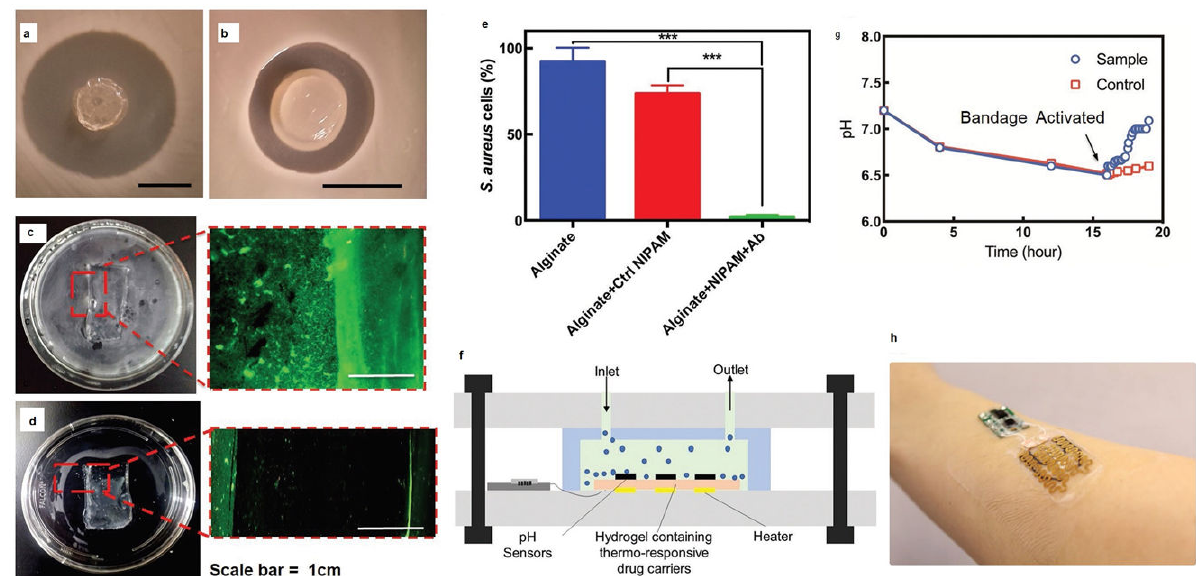
Figure 9. The antibacterial activity of the bandage was tested in vitro. ( a , b ) Antibacterial releasing hydrogel diffusion test and negative control (hydrogel without antibiotics). ( c ) On the control patch, live-dead due to biofilm development. ( d ) Live-dead staining on an antibacterial patch caused by biofilm formation; live bacteria appear as green. ( e ) Cefazolin- based CFU counting assay for S. aureus . ( f ) Schematics of an in vitro model for cultivating S. aureus bacteria in a bioreactor with a pH sensor and treated with an antibiotic patch. ( g ) In vitro test demonstrating pH variation over time, followed by heater activation at pH = 6.5. ( h ) The electronic component, pH sensors, microheater, and drug-loaded hydrogel are all integrated. The author’s hand was adorned with the patch; *** p ≤ 0.001. Copyright 2018 John Wiley@Sons. Reprinted with permission from ref.